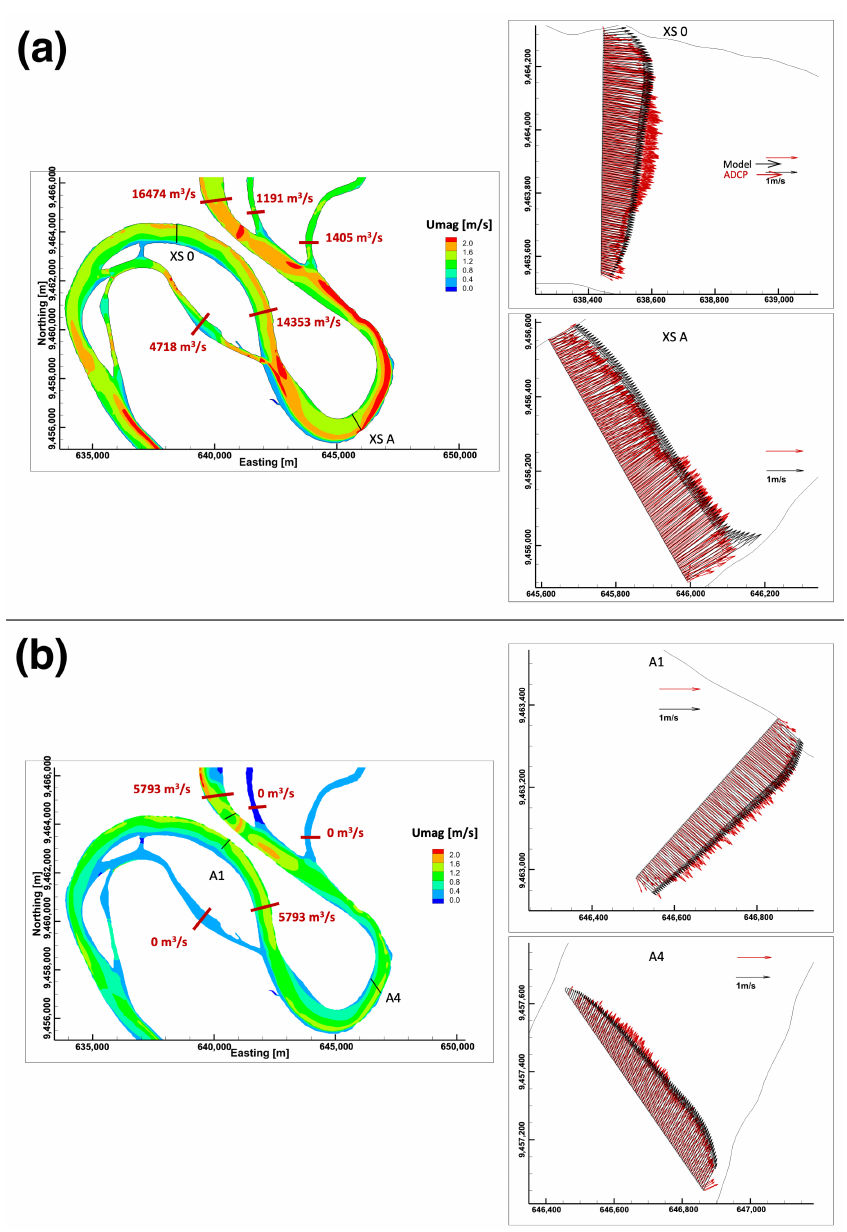
Figure 11. Comparison of measured and predicted depth-averaged velocities for: ( a ) May 2013 (stations XS0 and XSA) and ( b ) August 2013 (stations A1 and